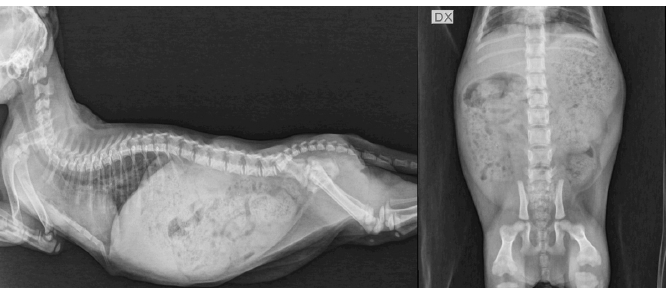
Figure 4. Lateral projection of thorax and abdomen and ventro ‐ dorsal projection of the abdomen the same hypothyroid kitten (F2) of Figure 3 at 83 days of age (after 1 month of levothyroxine treatment). Normal appearance of growth centers of long bones and vertebral bodies are visible. Moderate distension of the gastrointestinal tract was also present. DX, right side. The levothyroxine dose (20 μ g/kg q24h) was maintained unchanged at the first re ‐ evaluation in all 3 kittens while the amount of levothyroxine supplementation was adapted to the increasing body weight. The kittens were re ‐ evaluated several times during the following months, and the levothyroxine dosage was adjusted according to tT4/TSH concentrations (Table 2) and increasing BW. At the time of writing (365 days of age, 10 months after initiating therapy), the kittens are doing well (Figure 5), and the serum concentrations of tT4 and TSH had normalized (last levothyroxine dose: 10 μ g/kg [F1], 18 μ g/kg [F2], 20 μ g/kg [M1]). Figure 5. One of the 3 kittens (kitten F1) at 83 ( a ), 185 ( b ) and 365 days of age ( c ). 4.2. Body Weight Changes and IGF ‐ 1 Concentrations At birth, no differences in BW (median [g] and range) were observed among the CHk (87, 82–92), HS (67, 61–91), and BS (90, 52–137) kittens ( p = 0.11; Figure 6). At diagnosis (53 days of age), the CHk had a significantly lower BW as compared to their HS (600 [500– 600] vs. 805 [750–860], p = 0.03). Moreover, at 53 days of age, the BW of the CHk tended to be lower, although not significantly lower than that of the BS kittens (600 [500–600] vs. 710 [426–1020]; p = 0.06). The difference in BW between the CHk (1200, 1040–1300) and the HS (1500, 1400–1600) was no longer observed at 83 days of age after 1 month of levothyroxine treatment ( p = 0.26).